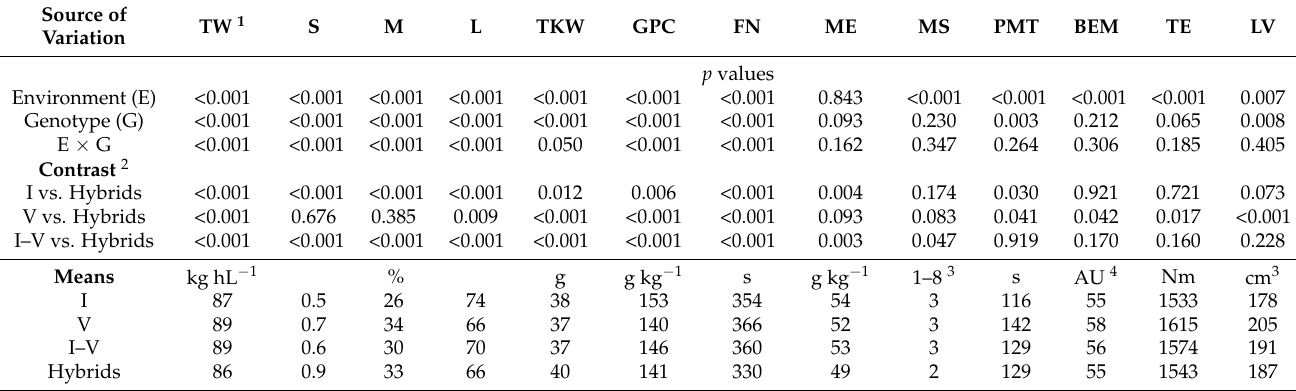
Significant dependent variables from the ANOVA for genotype were evaluated using single degree of freedom contrasts. 1 TW, test weight; S, M, L, small, medium, and large kernel distribution percent; TKW, 1000 kernel weight, GPC, grain protein content; FN, falling number; ME, milling extraction; MS, mixograph score; PMT, peak max time; BEM, torque maximum; TE, total energy; LV, loaf volume. 2 I, Ingmar; V, Valda. 3 Mixograph score where 1 is low mixing tolerance and 8 is high mixing tolerance. 4 AU, Ambiguous